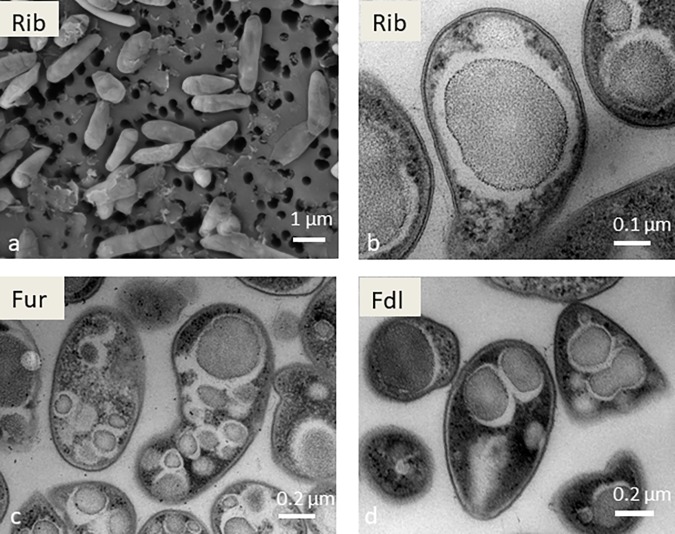
Scanning electron microscopy image of strain Rib (a) and transmission electron microscopy images of strains Rib (b), Fur (c), and Fdl (d). Scale bars are shown at the bottom right in all images.